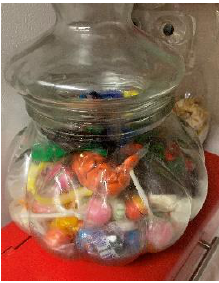
Figure 7. Candy jar on kitchen counter (photograph submitted by family).